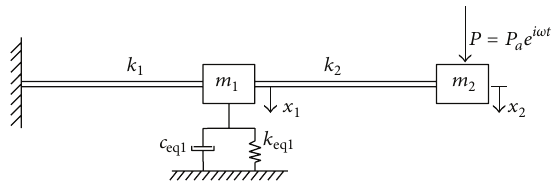
Figure 3: Simplified damping blade with lacing structure.